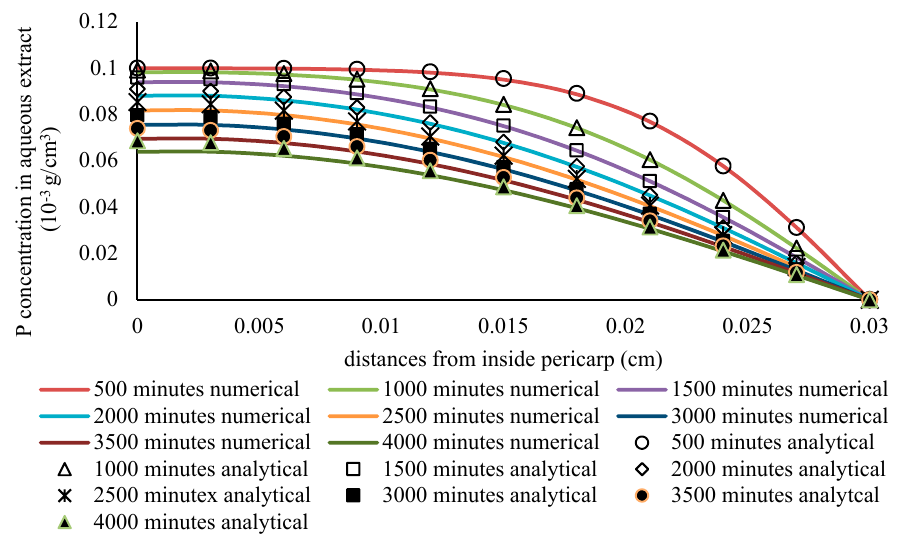
Table 2. The parameter values of the model based on experimental data from the extraction process. Temperature (°C)